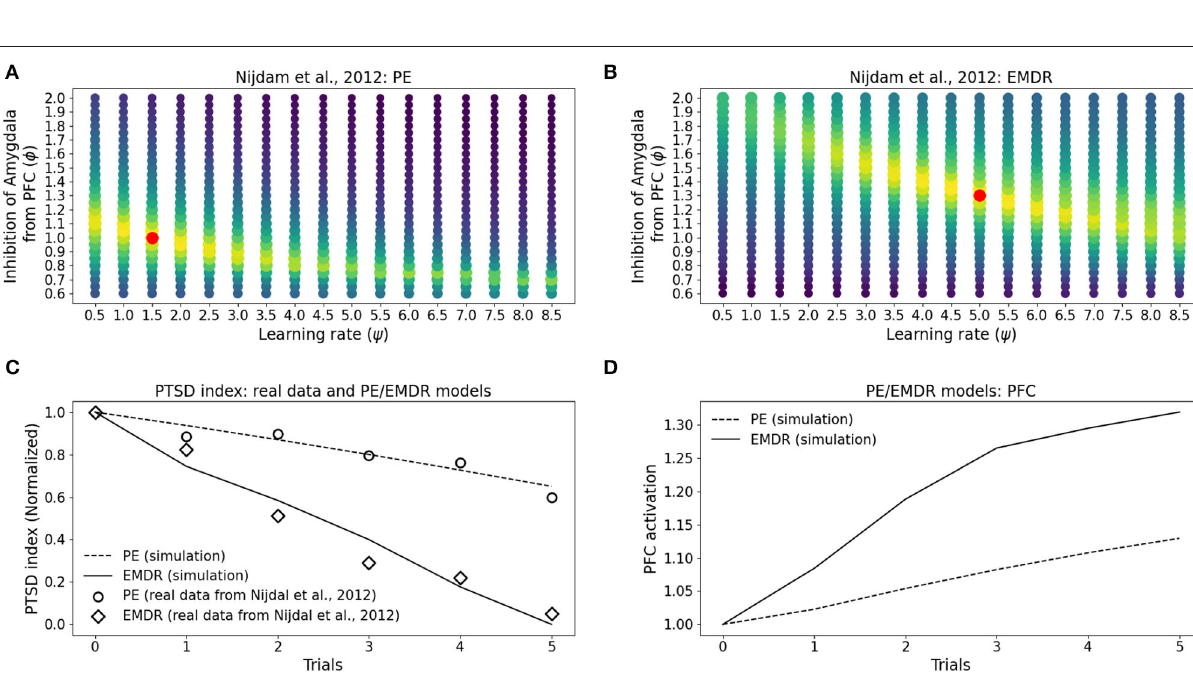
Frontiers in Psychology |